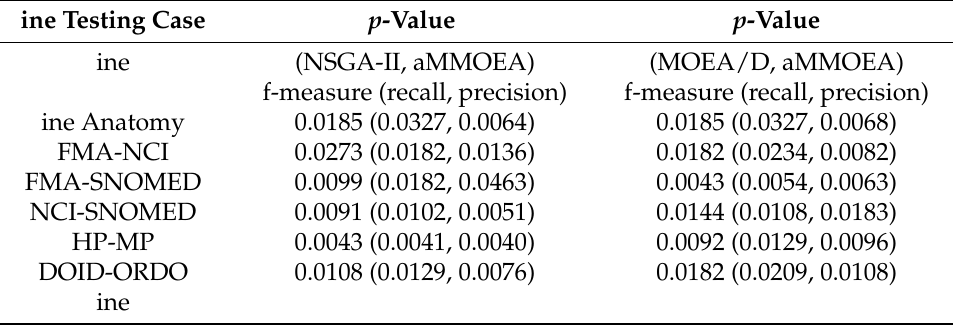
Table 5. t -Test’s p -value on the alignment’s